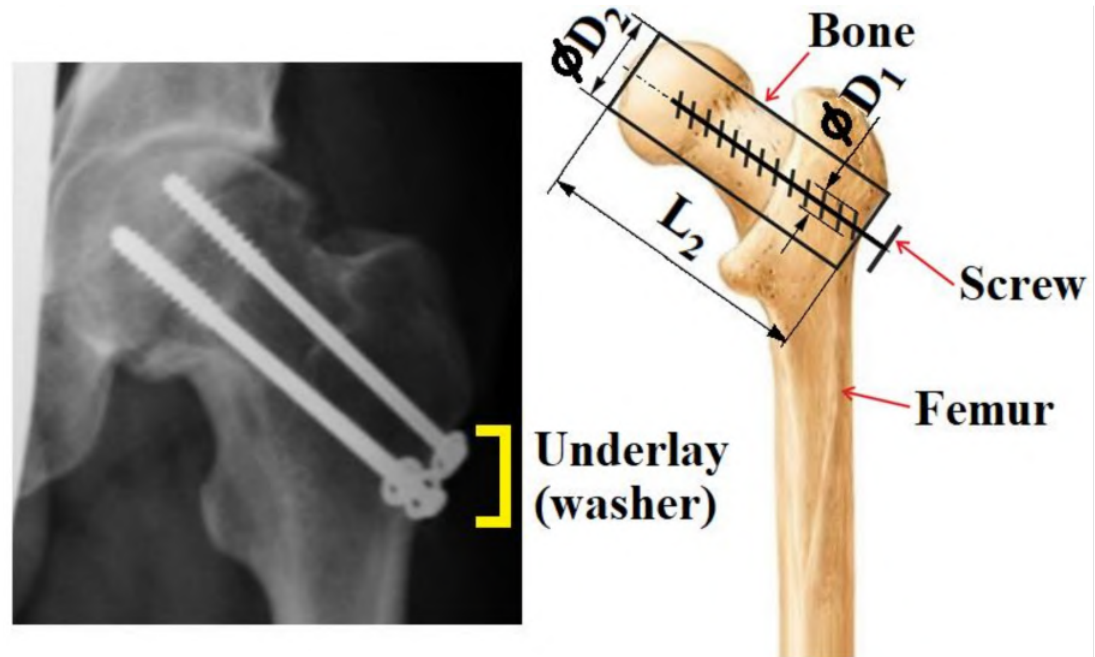
Figure 11. Biomechanics of human os femoris with factura collum femoris , osteosynthesis and application of a bone screw in connection with experiments.